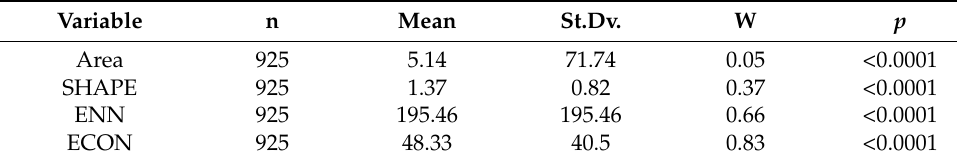
Table A2. Shapiro-Wilks’s goodness-of-fit tests for the landscape metrics at patch level.